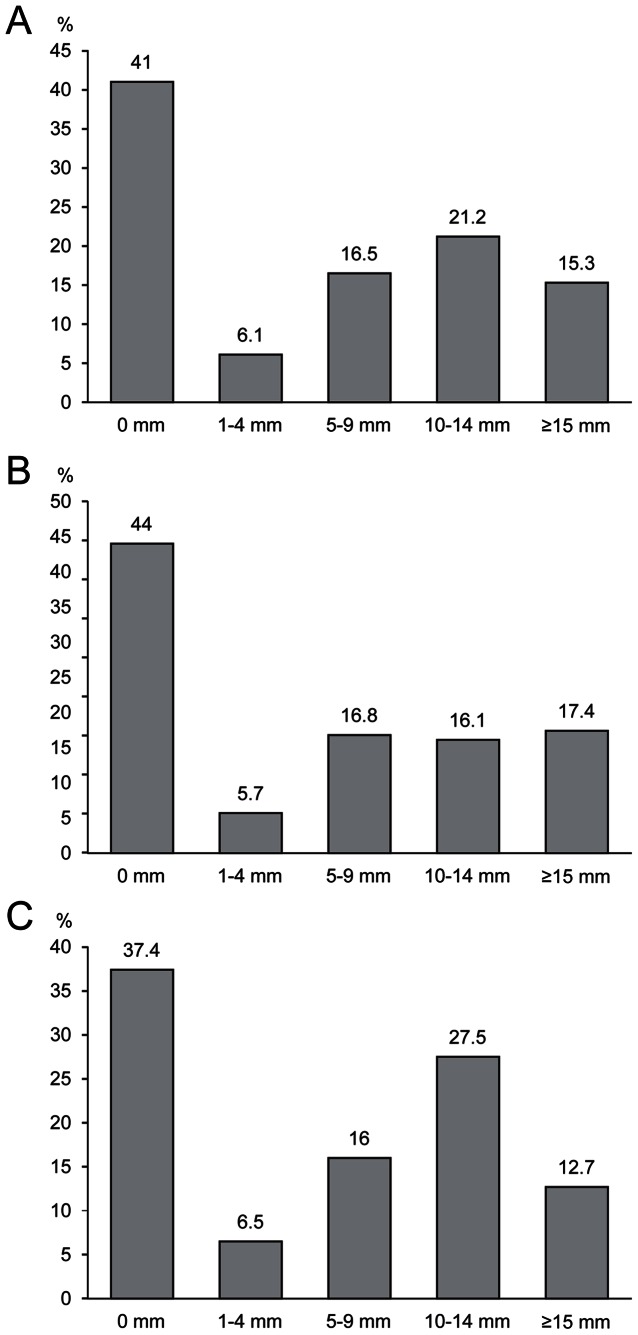
Distribution of tuberculin skin test reactions.A. Overall. B. One-step period. C. Two-step period.